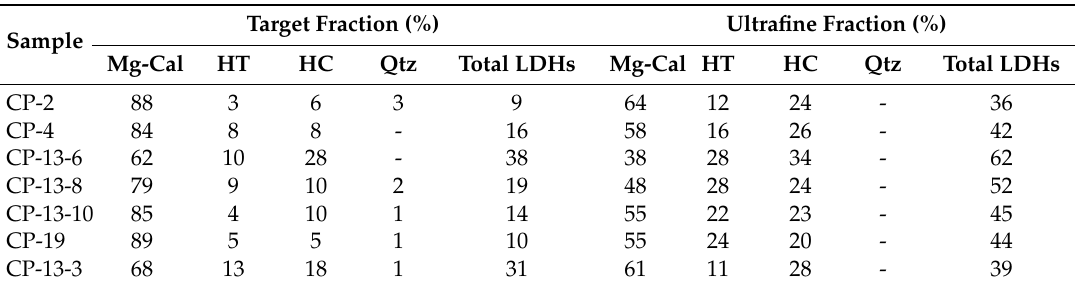
Table 2. Semi-quantitative data results (%) of X-ray diffraction analyses of target and ultrafine fractions of mortar binders.